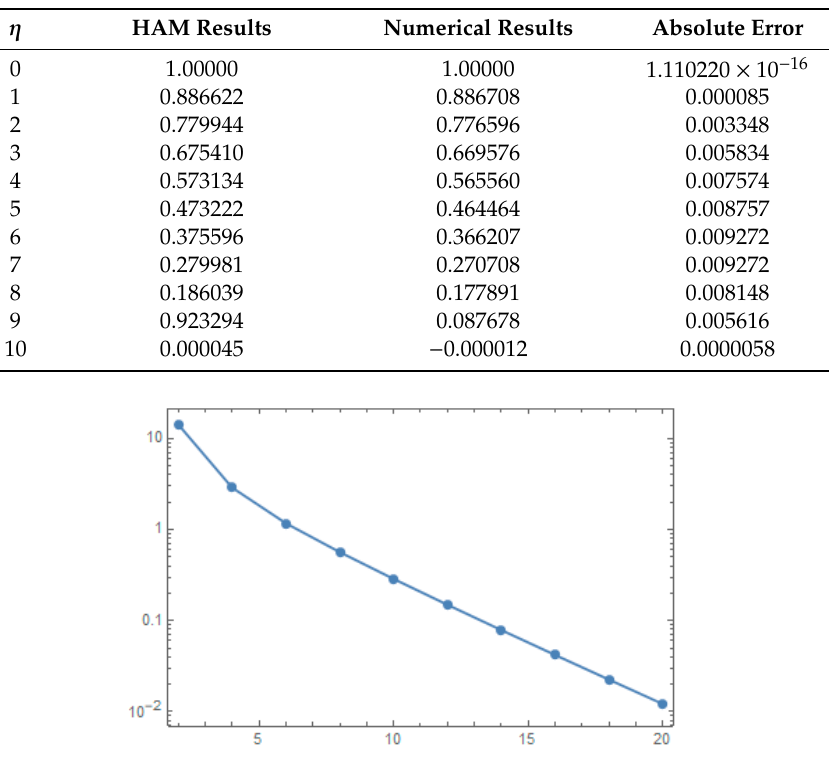
Figure 18. Error decay for the 10th-order approximation. Table 3. Comparison results for sphere-shaped nanoparticles.